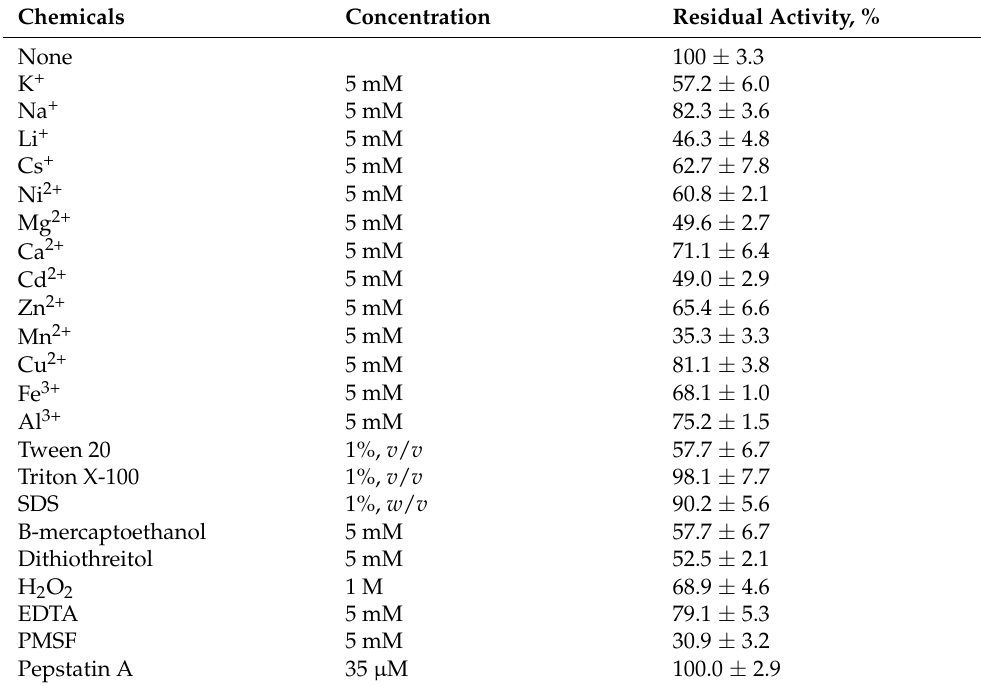
Table 1. Effects of various chemicals on keratinolytic activity of the Bacillus sp. A5.3 extract.